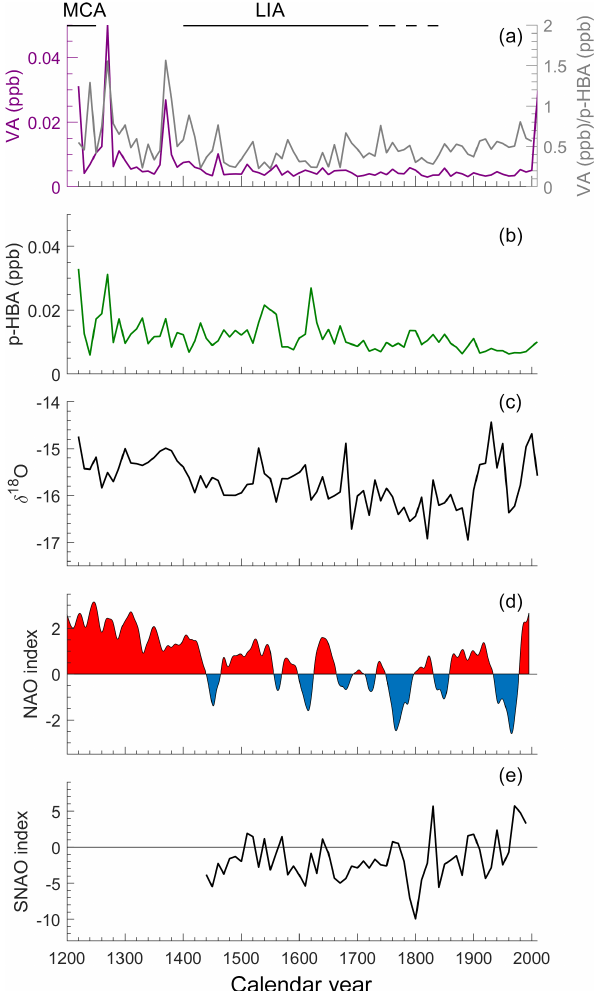
Figure 8. Comparison of the timing of aromatic acid signals in the Lomonosovfonna ice core over the past 800 years compared to other climate-related proxy records. From top: (a) 10-year bin aver- ages of Lomonosovfonna vanillic acid (violet line), ratio of vanillic acid/ p -hydroxybenzoic acid (gray line), and (b) p -hydroxybenxoic acid; (c) 10-year bin averages of the oxygen isotope record from the Lomonosovfonna ice core (Wendl et al., 2015); (d) North Atlantic Oscillation (NAO) index (red > 0; blue < 0; Trouet et al., 2009); and (e) 10-year bin averages of the summer North Atlantic Oscillation (SNAO) index (Linderholm et al., 2009). The black horizontal lines are the timing of the Medieval Climate Anomaly (MCA) and the Little Ice Age (LIA) (Mann et al., 2009). The dashed horizontal line is the extended LIA in the Svalbard region (Divine et al., 2011).